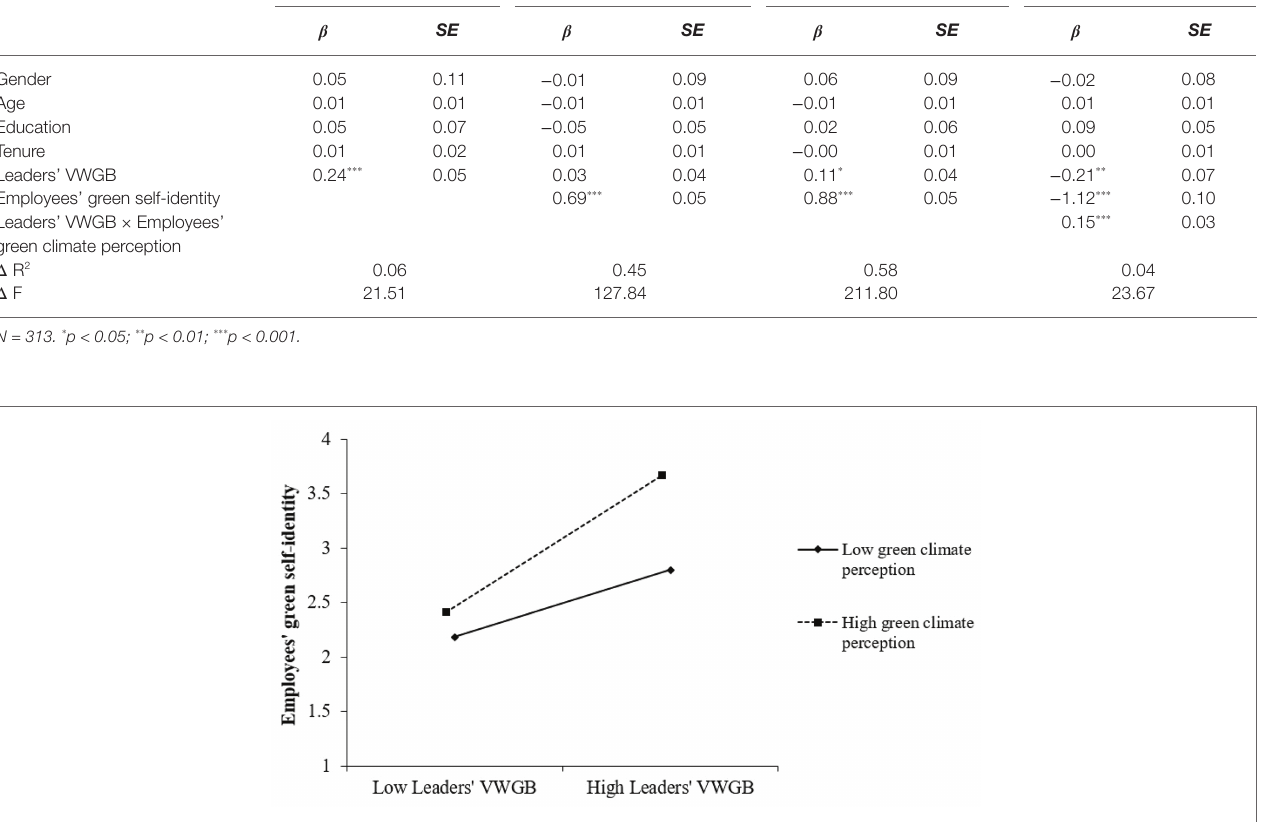
FIGURE 2 | The moderating effect of green climate perception on the relationship between leaders’ VWGB and employees’ green